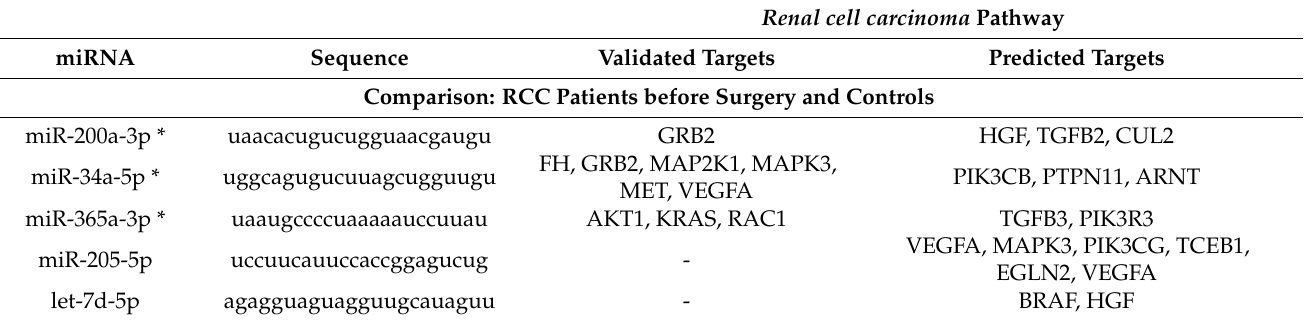
Table 4. Validated and predicted targets of the miRNAs dysregulated in RCC patients. These target proteins were identified using miRWalk 2.0 and were further integrated within the renal cell carcinoma pathway from KEGG. Validated targets are those that have been empirically validated to be regulated by a miRNA. Predicted targets are those that have been theoretically estimated based the free binding energy between a miRNA and a putative target mRNA sequence.